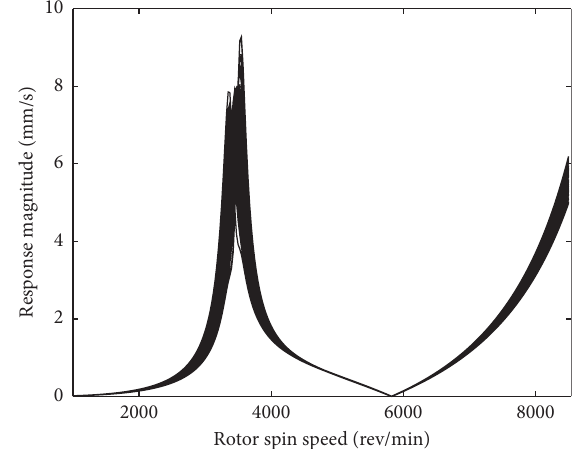
Figure 13: Uncertainty analysis of frequency response function at